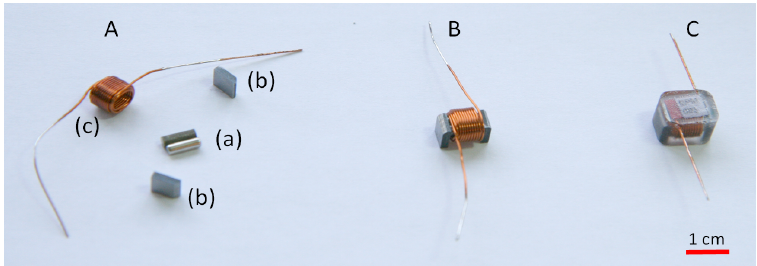
Figure 13. ( A ) An EPM is composed of two magnet rods of different coercivities, but similar remnant fields (a), sandwiched between two iron pole pieces (b), and wrapped with 32 turns of grade 26 American wire gauge (AWG) wire (c); ( B ) The pieces are hold together using glue; ( C ) The assembly is then put in a polyurethane mold for protection against rusting